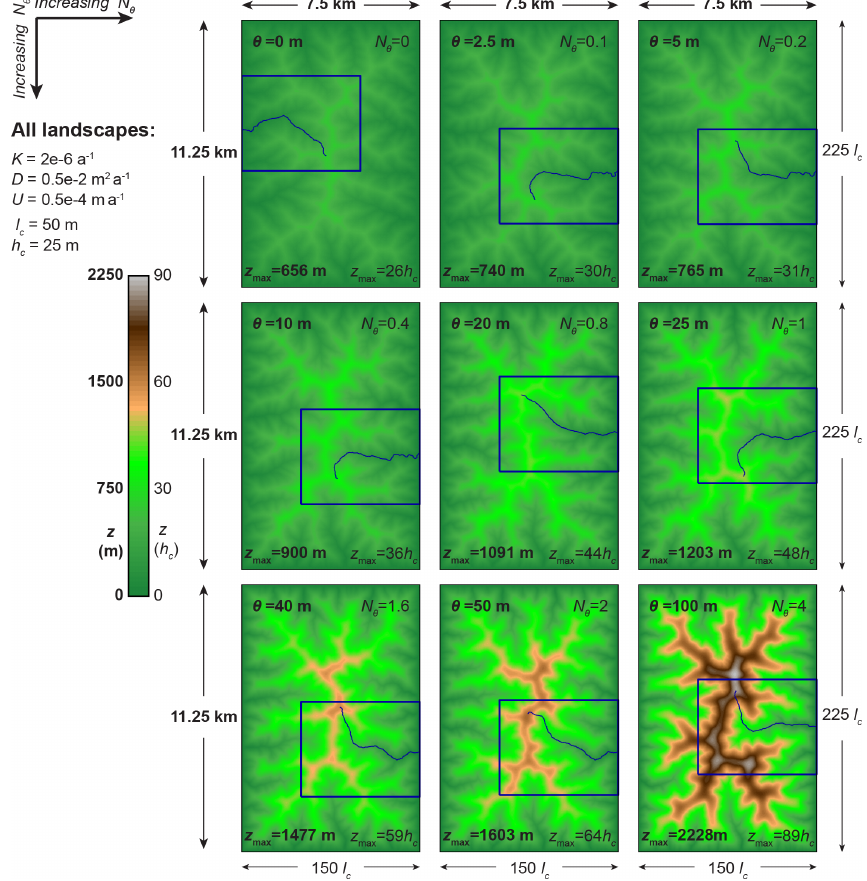
Figure 6. Increase in relief as the incision-threshold number N θ increases. Steady-state elevation maps of the nine landscapes of Sect. 3.2 (parameter values in Table 4) are plotted using a single elevation color scale, facilitating visual comparison of elevations across landscapes. The blue lines show the longest flow path of each landscape, and the blue rectangles mark the regions that are magnified in Figs. 5, 7, and 8. The landscapes are arranged such that N θ increases from left to right and from top to bottom. By comparing the colors of the maps, we observe that landscapes with higher N θ values have greater relief (see also the maximum elevation of each landscape, displayed at the bottom of each